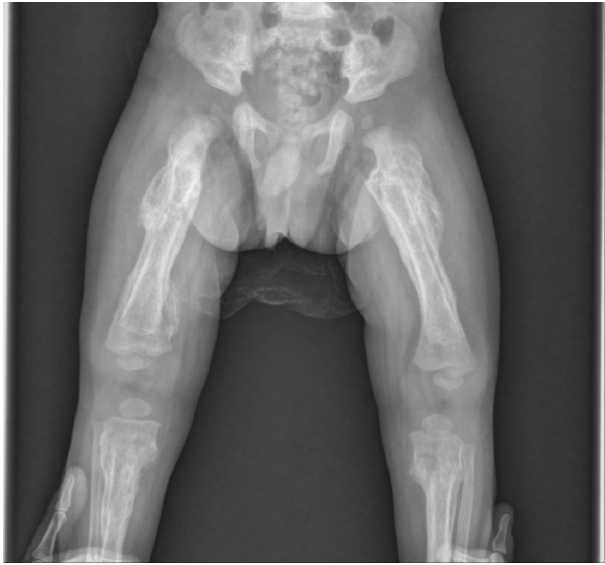
Figure 4. After 3 months, radiographical findings showed that the fracture was healed and remod- eled.